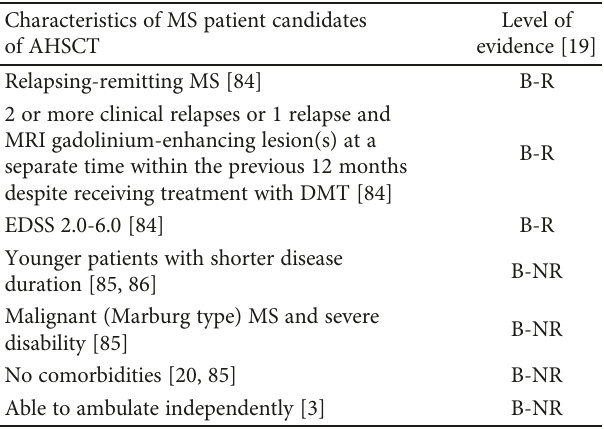
Table 1: Characteristics of MS patient candidates for